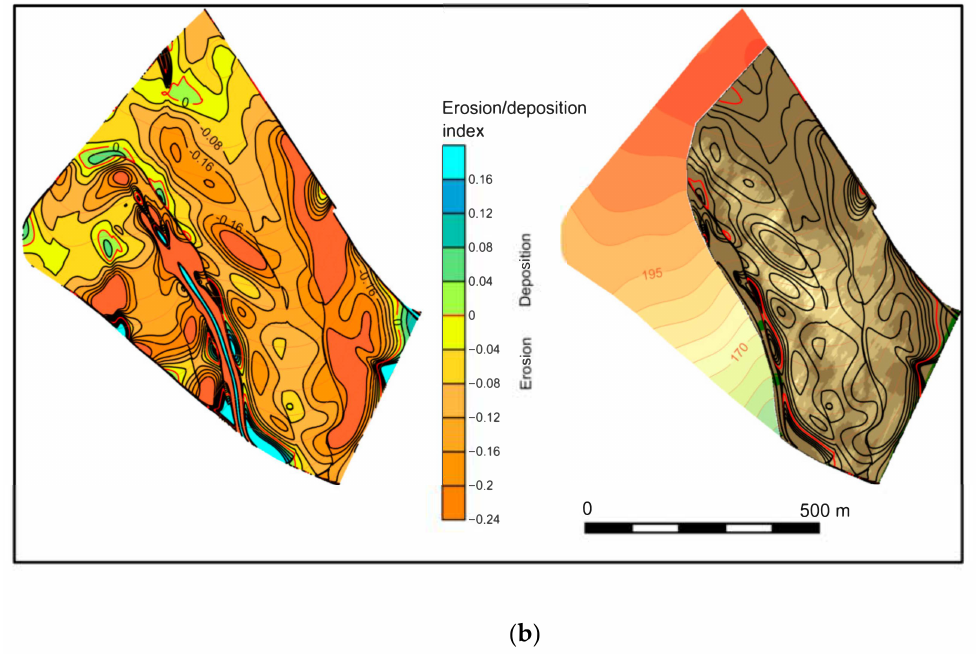
Figure 4. Isoline field: topographic factor LS ( a ), erosion / deposition index ED’ ( b ). Each parameter is expressed by two figures, the left image showing the isoline field and the right image showing the overlay of the isoline field and erosion pattern obtained by object-based classification. Table3.